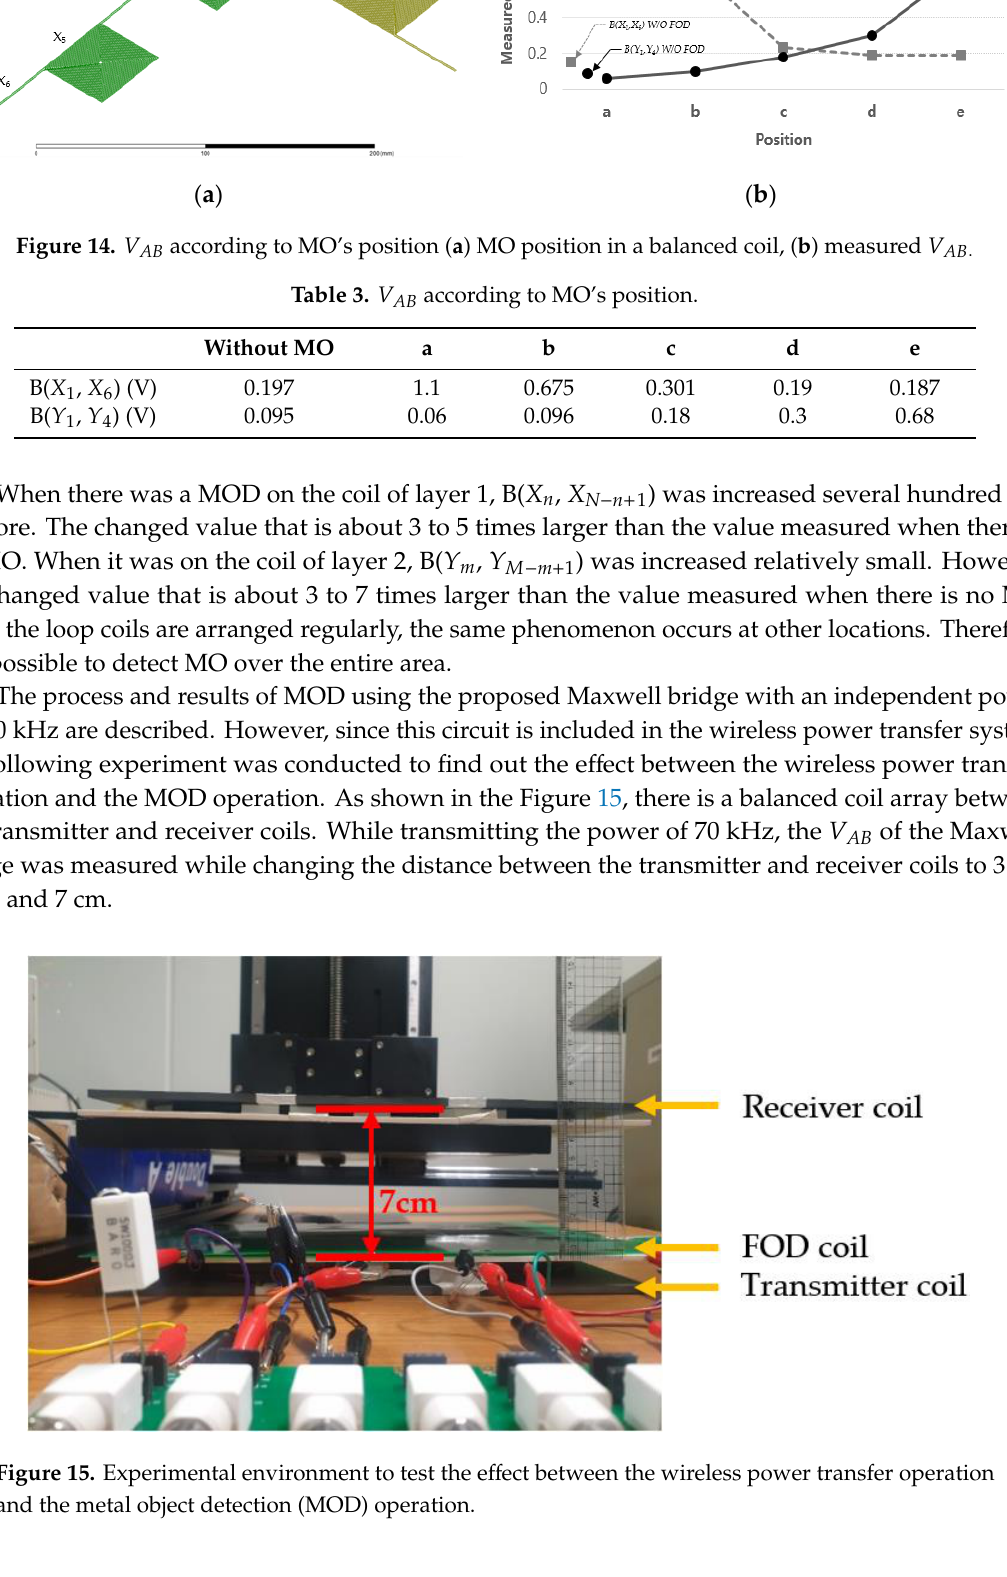
Figure 15. Experimental environment to test the effect between the wireless power transfer operation and the metal object detection (MOD) operation.